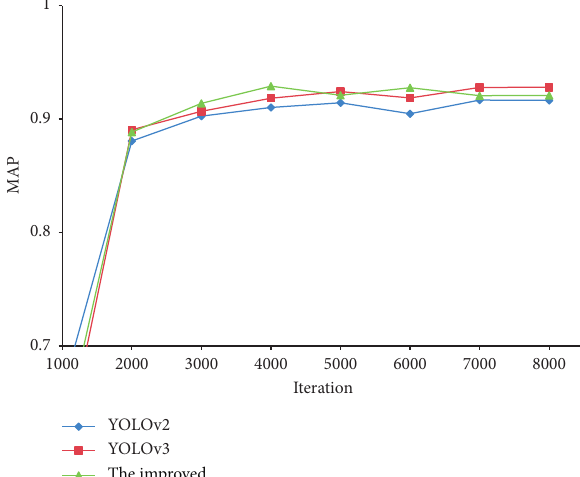
Figure 15: The comparison of mAP among YOLOv2/v3 and the improved RDCNN under the testing-set.